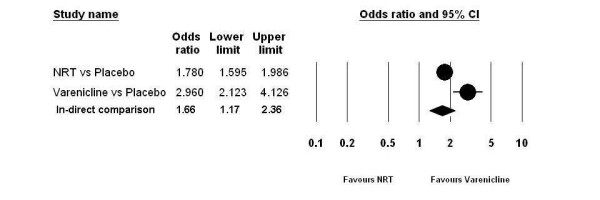
Indirect comparison between Varenicline and NRT vs Placebo at 12 months. Bucher et al. indirect comparison methods [28].